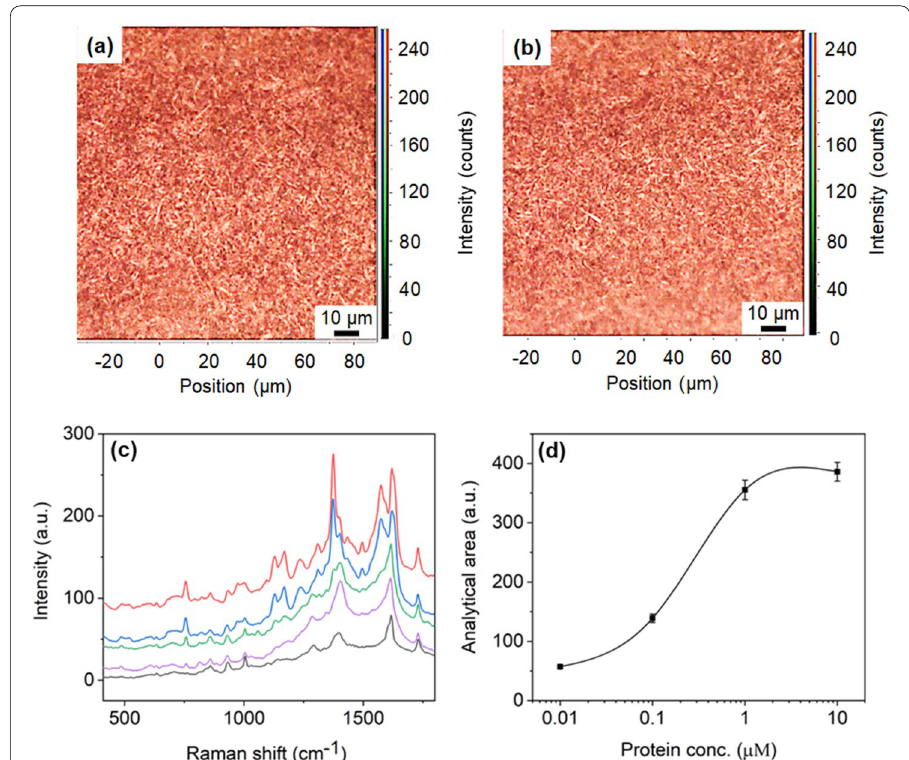
Fig. 3 AFM tomography of AgNWs/PET chips a before and b after incubation in a Mb aqueous solution. c , d SERS detection with AgNWs/PET chips. c SERS spectra of Mb solutions with concentrations ranging from 10 − 8 M to 10 –5 M (black, naked chip; violet, 10 –8 M; green, 10 –7 M; blue, 10 − 6 M; red, 10 –5 M). d Correlation between the 756 cm − 1 band area and protein concentration (error bars represent the standard